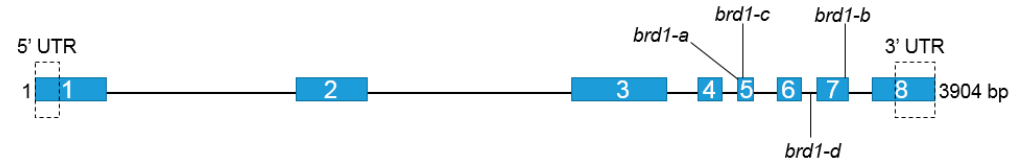
Figure 1. The HvDWARF gene structure with exons depicted as blue rectangles with consecutive numbers and introns as black line. Positions of the mutations identified in the brd1-a , brd1-b , brd1-c and brd1-d alleles are shown.